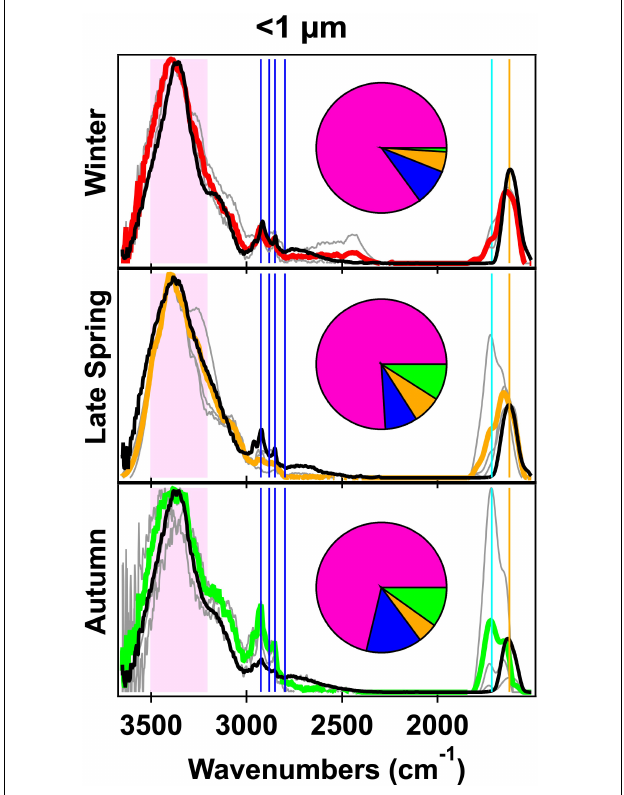
FIGURE 2 | Fourier transform infrared spectroscopy (FTIR) spectra normalized to the alcohol group peak of the < 1 µ m atmospheric primary marine aerosol (aPMA) seasonal averages (Winter in red, Late Spring in orange, and autumn in green) and generated primary marine aerosol (gPMA) (black) averages with the individual aPMA spectra shown in gray. The pie charts show the average organic functional group (OFG) composition with hydroxyl (pink), alkane (blue), amine (orange), and acid (green) groups. The spectral peak locations for the OFG are indicated with the hydroxyl region in the shaded pink area, four alkane peaks (vertical blue lines), carbonyl (both acidic and non-acidic, vertical teal line), and amine (vertical orange